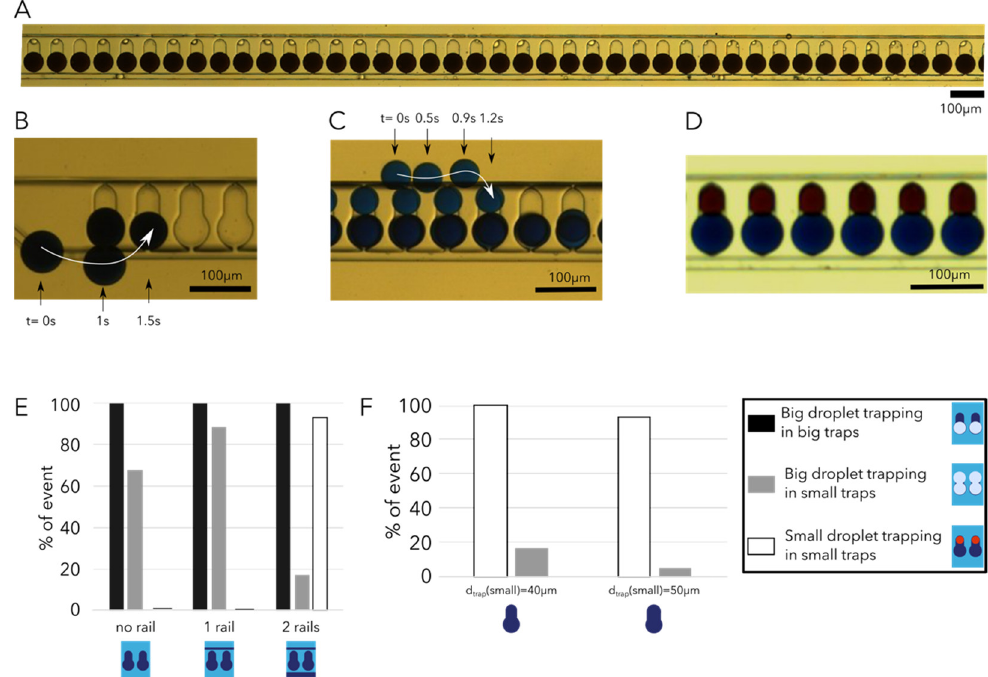
Figure 4. Droplet trapping array. ( A ) Brightfield image of big droplets trapped. ( B ) Time-lapse of a big droplet being trapped in the second trap of the array. ( C ) Time-lapse of a small droplet being trapped at the 90th trap of the array. ( D ) Brightfield image of six traps containing a single droplet of each type (two different dyes). The white arrows indicate the trajectories of the droplets. ( E ) Histogram of the big droplet trapping efficiency in big traps and small traps (double trapping) as well as the small droplet trapping efficiency in small traps under the conditions of no rail, a single rail or two rails present, for the same trap dimensions (big trap diameter of 60 µ m, small trap diameter of 40 µ m and trap height of 40 µ m). ( F ) Histogram of the small and big droplet (double trapping) trapping in small traps according to the small droplet trap diameter (big traps have a diameter of 60 µ m and height of the traps 40 µ m). Videos are available in the Video S3.